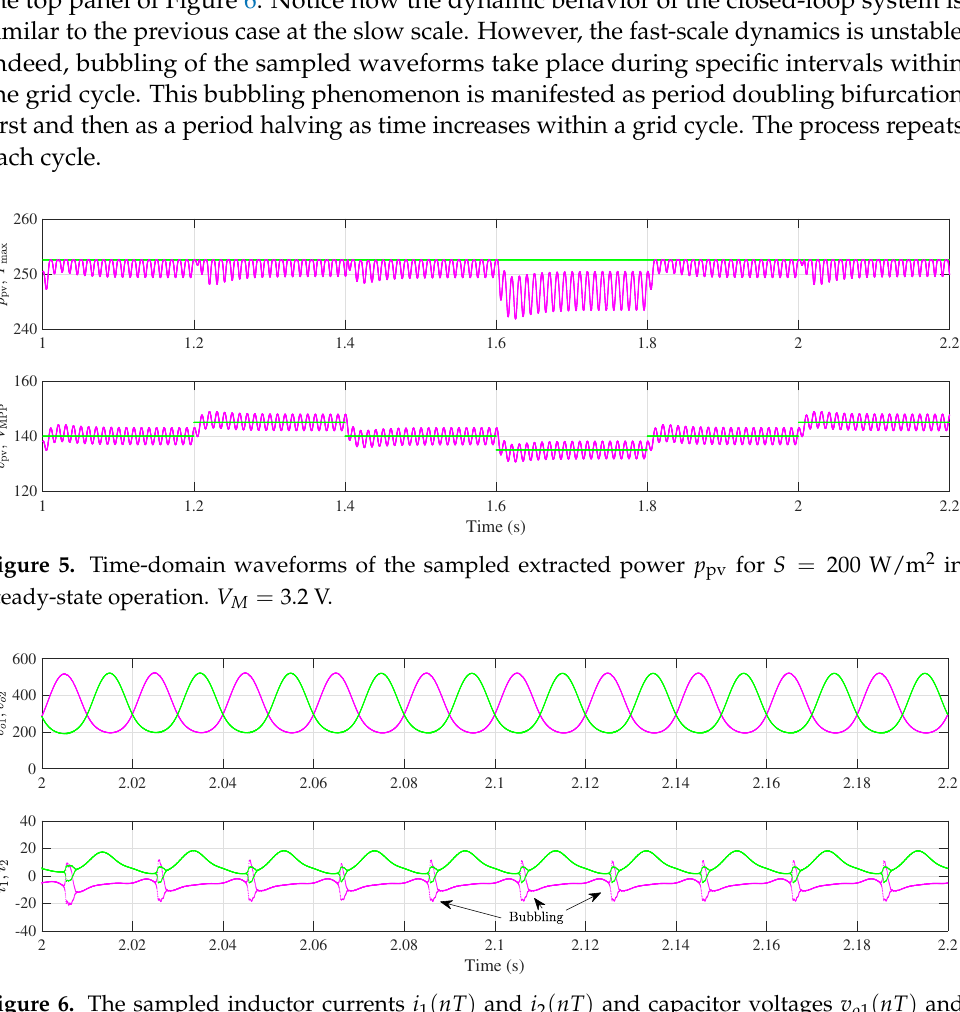
Figure 6. The sampled inductor currents i 1 ( nT ) and i 2 ( nT ) and capacitor voltages v o 1 ( nT ) and v o 2 ( nT ) for S = 200 W/m 2 in steady-state operation. V M = 3.2